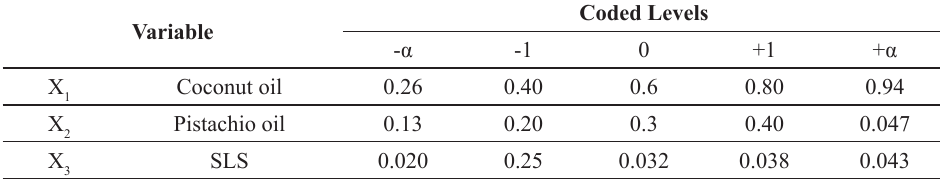
Coded levels and values of the independent